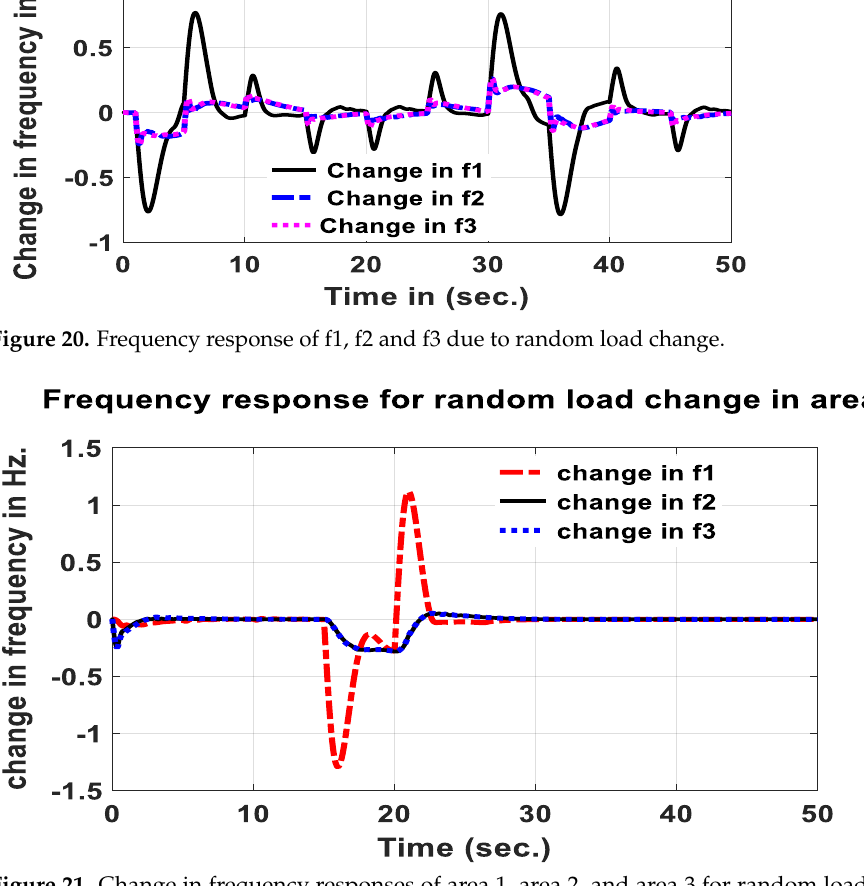
Figure 21. Change in frequency responses of area 1, area 2, and area 3 for random load change in area 1 only.